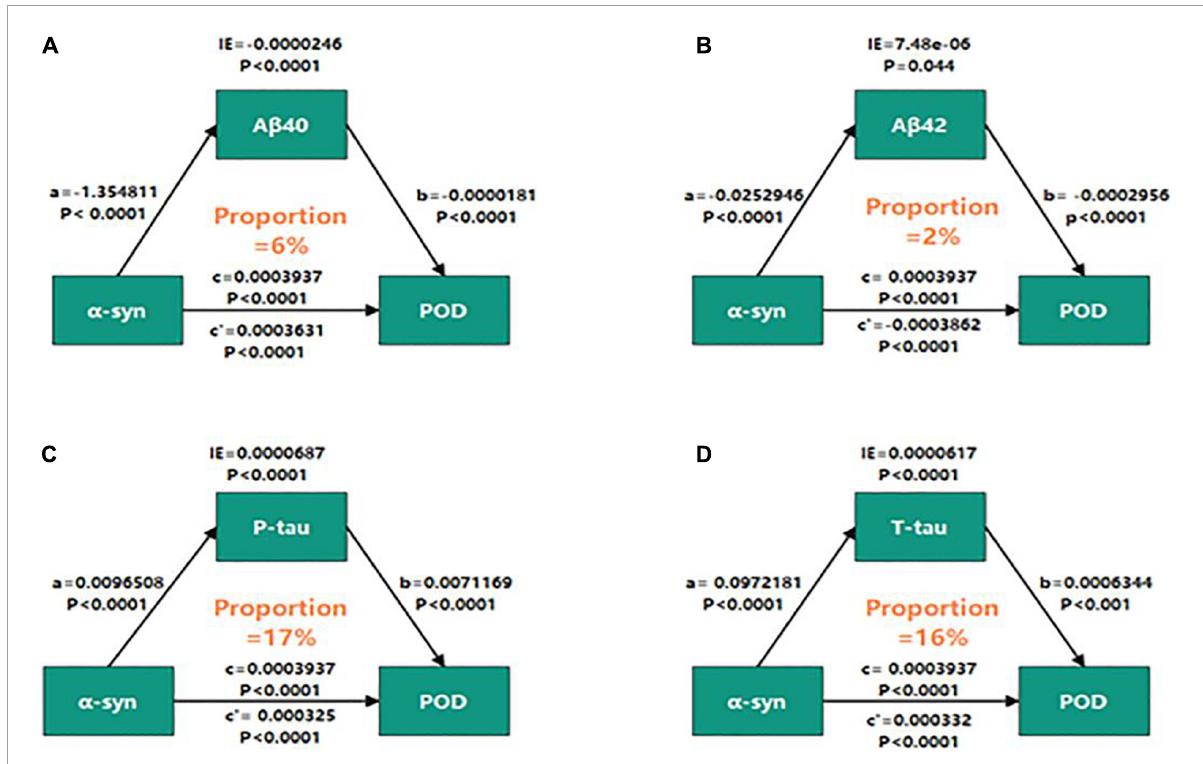
FIGURE4 Mediation analyses with 5,000 bootstrapped iterations were used to examine mediation effects of A β 40 (A) , A β 42 (B) , P-tau (C) , and T-tau (D) on POD. CSF, cerebrospinal fluid; IE, indirect effect; α -syn, α -synuclein; A β 40, amyloid- β 40; A β 42, amyloid- β 42; T-tau, total Tau; P-tau, phosphorylated